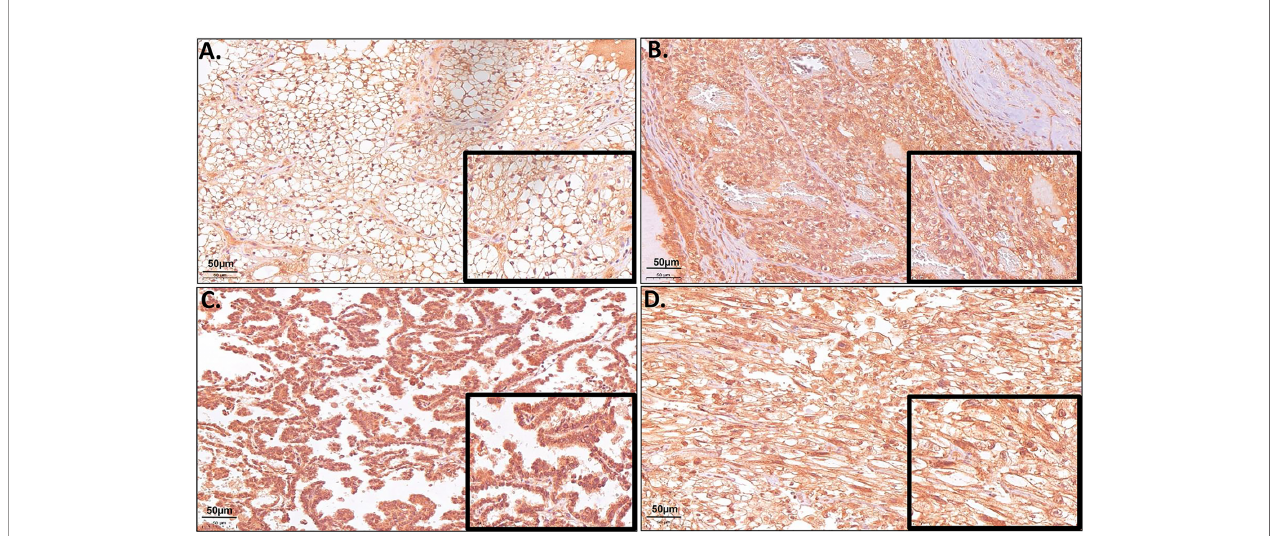
FIGURE 2 | Representative microscopic images of TMA samples of different RCC tumor subtypes hybridized with a speci fi c ERV-K env antibody. (A) Example of a ccRCC (Tumor #21 TMA I) with strong protein expression of ERV-K env at the cell membrane. (B) Example of a ccRCC (Tumor #23 TMA I) with strong cytosolic enrichment for ERV-K env protein. (C) Example of a RCC papillary tumor with strong cytosolic enrichment for ERV-K env protein (Tumor #28 TMA II). (D) Example of a ccRCC with sarcomatoid features (Tumor #20 TMA III) with strong membranous as well as a partly cytosolic ERV-K env staining. Bar indicates